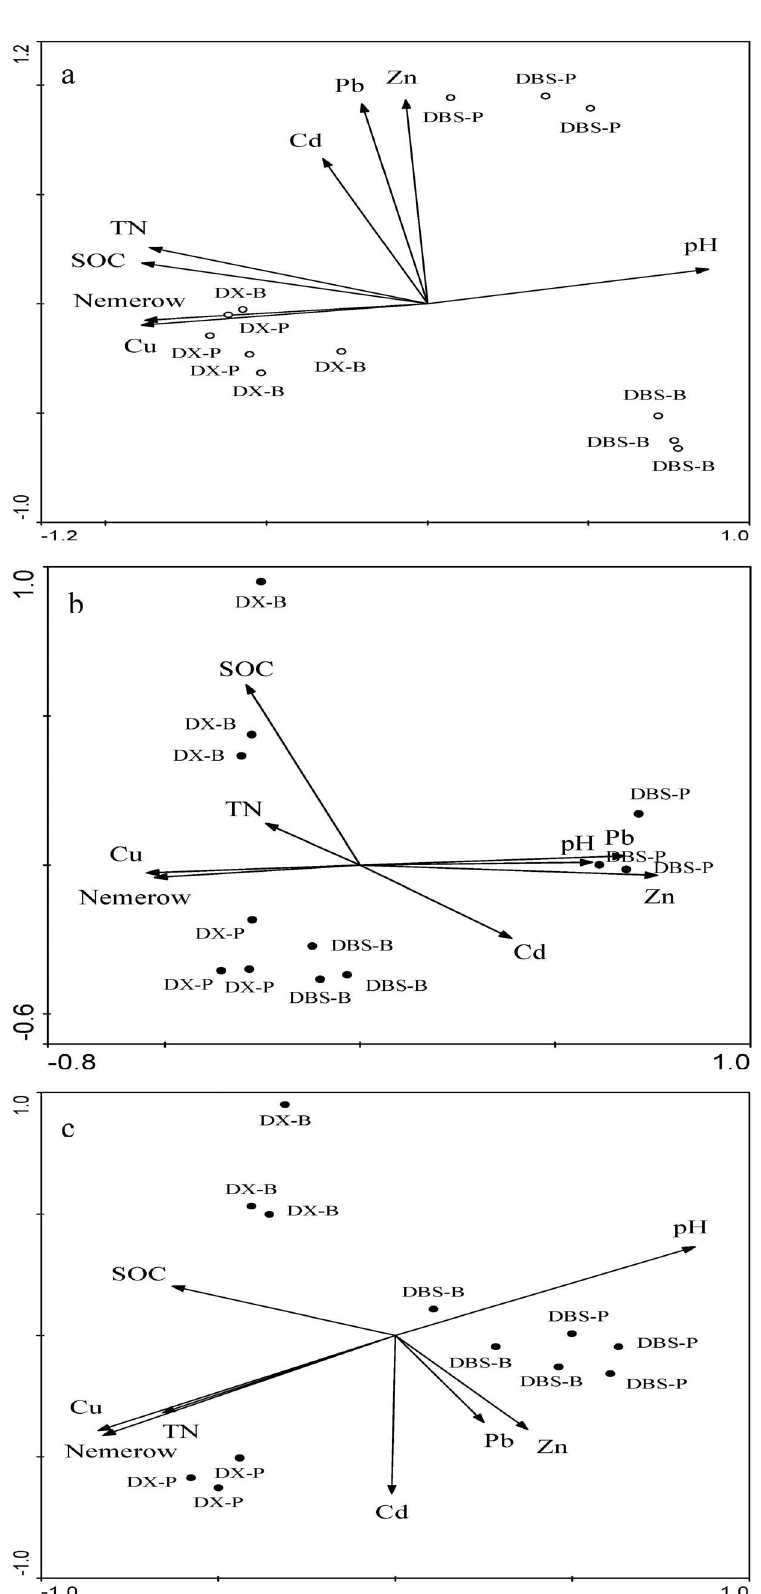
Figure 5. Redundancy analysis ordination plots of relationships between DGGE patterns of AOB (a), AOA (b) and nirK (c) gene and soil properties from the soil samples at the two sites. Soil properties included nemerow toxicity index, soil pH, SOC, TN, total concentration of Cd, Pb, Cu and Zn. DX-B and DBS-B, background soil from site DX and DBS; DX-P and DBS-P, polluted soil from site DX and DBS.